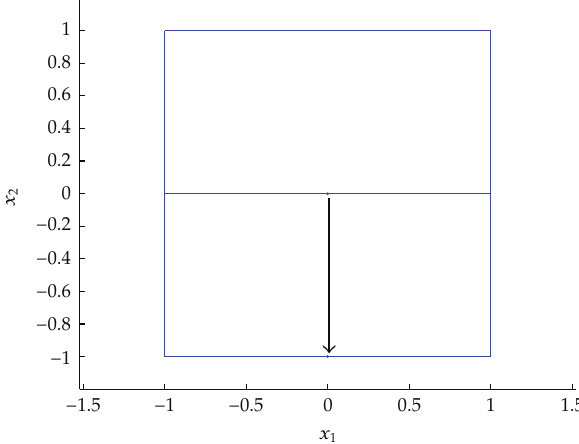
Figure 18: Feasible region of LP and the cut through the point (cid:2) 0 , 0 (cid:3) .